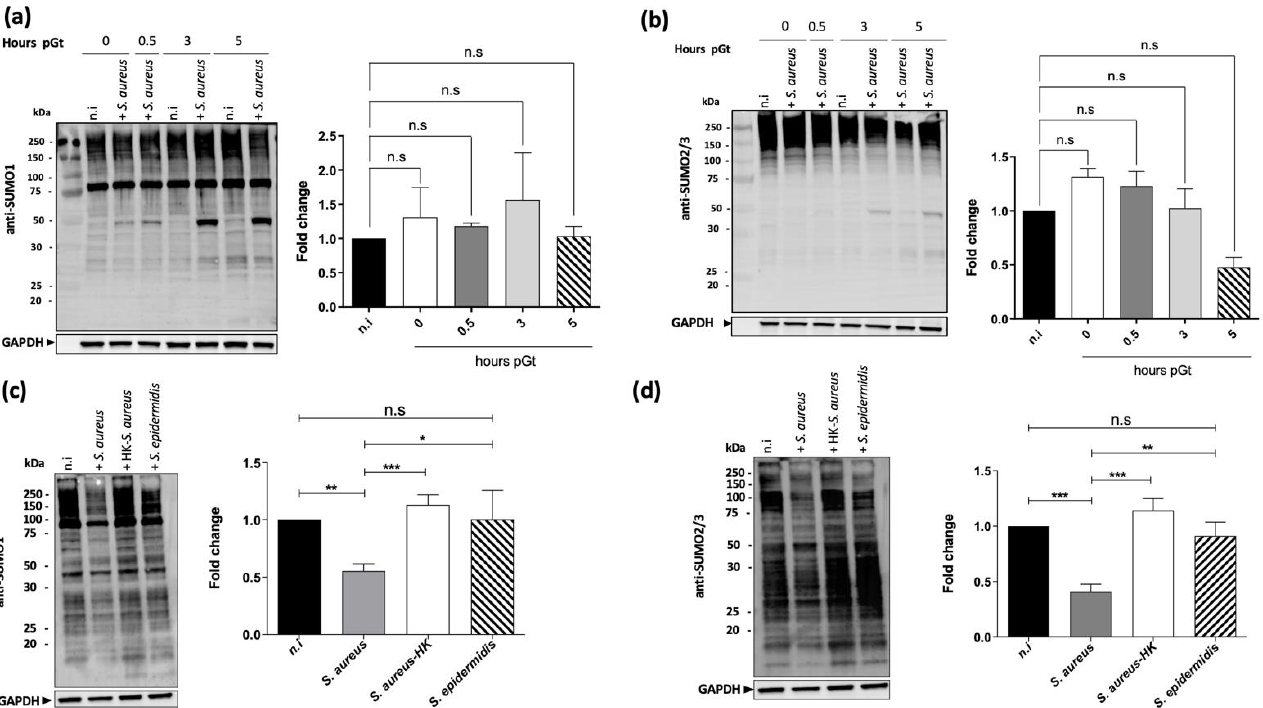
Figure 2. S. aureus decreases SUMOylation after long-term macrophage infection. Immunoblot analysis of SUMO1 ( a ), SUMO2/3 ( b ), and GAPDH levels in lysates of macrophages infected with S. aureus for different time points up to 5 h pGt. SUMO1 and SUMO2/3 smears were quantified from four independent experiments using Image lab software (ChemiDoc) and normalized to GAPDH (right panels). The fold change graph represents the percentage of SUMOylated proteins by SUMO1 obtained in the infected cells compared to the amount of SUMOylated proteins in the non-infected control macrophages. The data presented are the mean ± SD of three independent biological experiments. n.s, not significant (Kruskal–Wallis test followed by Dunn’s post hoc test). ( c , d ) Immunoblot analysis of SUMO1 ( c ), SUMO2/3 ( d ) and GAPDH levels in lysates of macrophages infected with S. aureus , heat-killed S. aureus and S. epidermidis for 24 h pGt. n.i., non-infected control cells. SUMO1 and SUMO2/3 smears were quantified from four independent experiments using Image lab software (ChemiDoc) and normalized to GAPDH (bottom panels). The fold change graph represents the percentage of SUMOylated proteins by SUMO1 obtained in the infected cells compared to the quantity of SUMOylated proteins in the non-infected control cells (right panels). *** p ≤ 0.001; ** p ≤ 0.01; * p ≤ 0.05 by one - way ANOVA with Bonferroni’s multiple -comparison test .